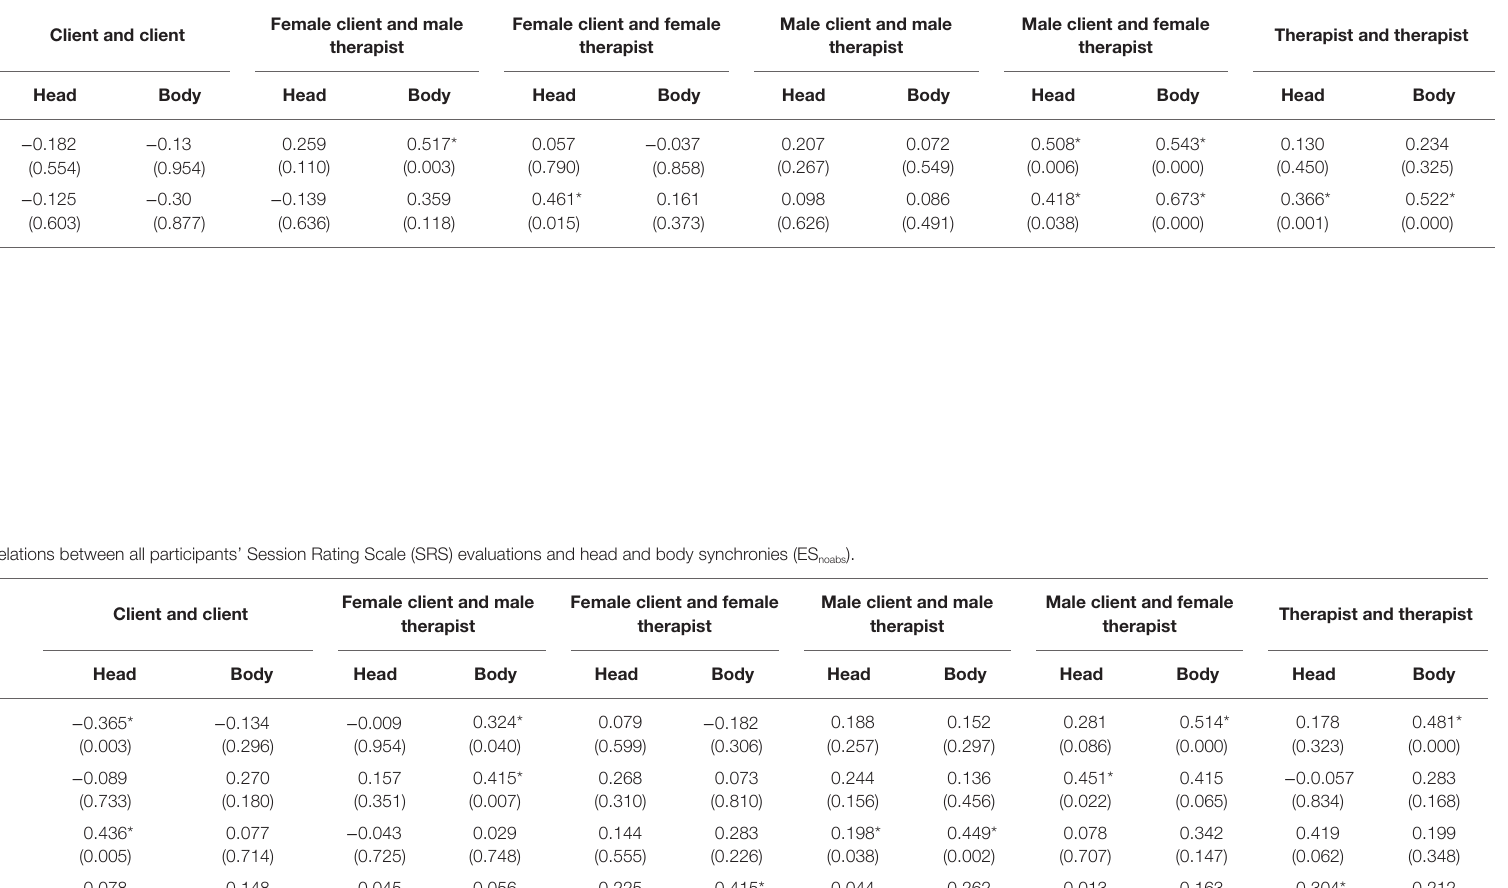
TABLE 6 | The relations between the clients’ Outcome Rating Scale (ORS) and head and body synchronies (ES noabs ).